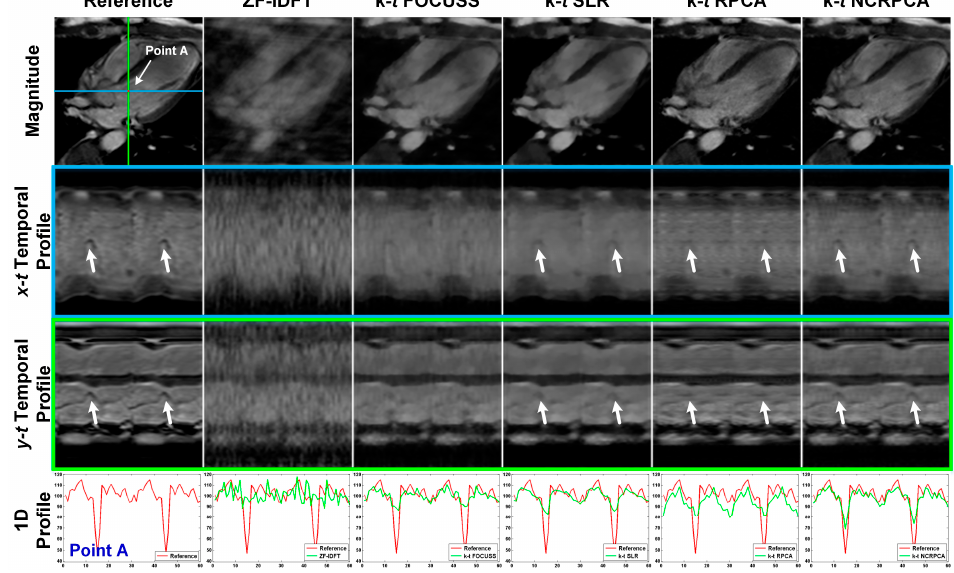
Figure 6. Qualitative results for in vivo coronal cardiac dataset with eight radial projections. From top to bottom: time-frame magnitude images, x - t temporal profiles, y - t t emporal profiles, and 1D profiles (according to the point A on the reference image). (The images are best viewed in full-screen mode.)